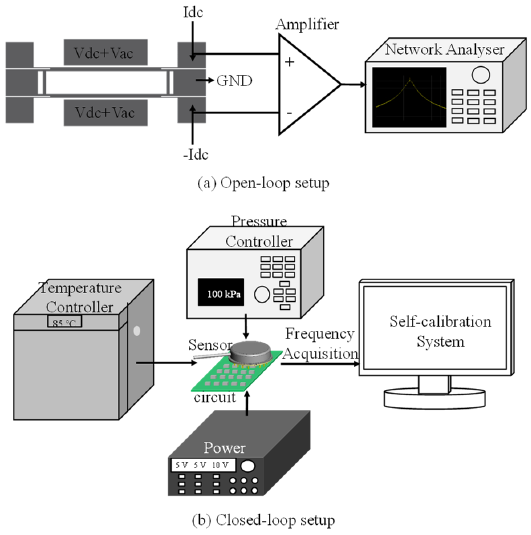
Figure 5. Schematic of open-loop ( a ) and closed-loop ( b ) platforms to characterize the developed resonant pressure sensors with variations of pressure and temperature parameters well under control.